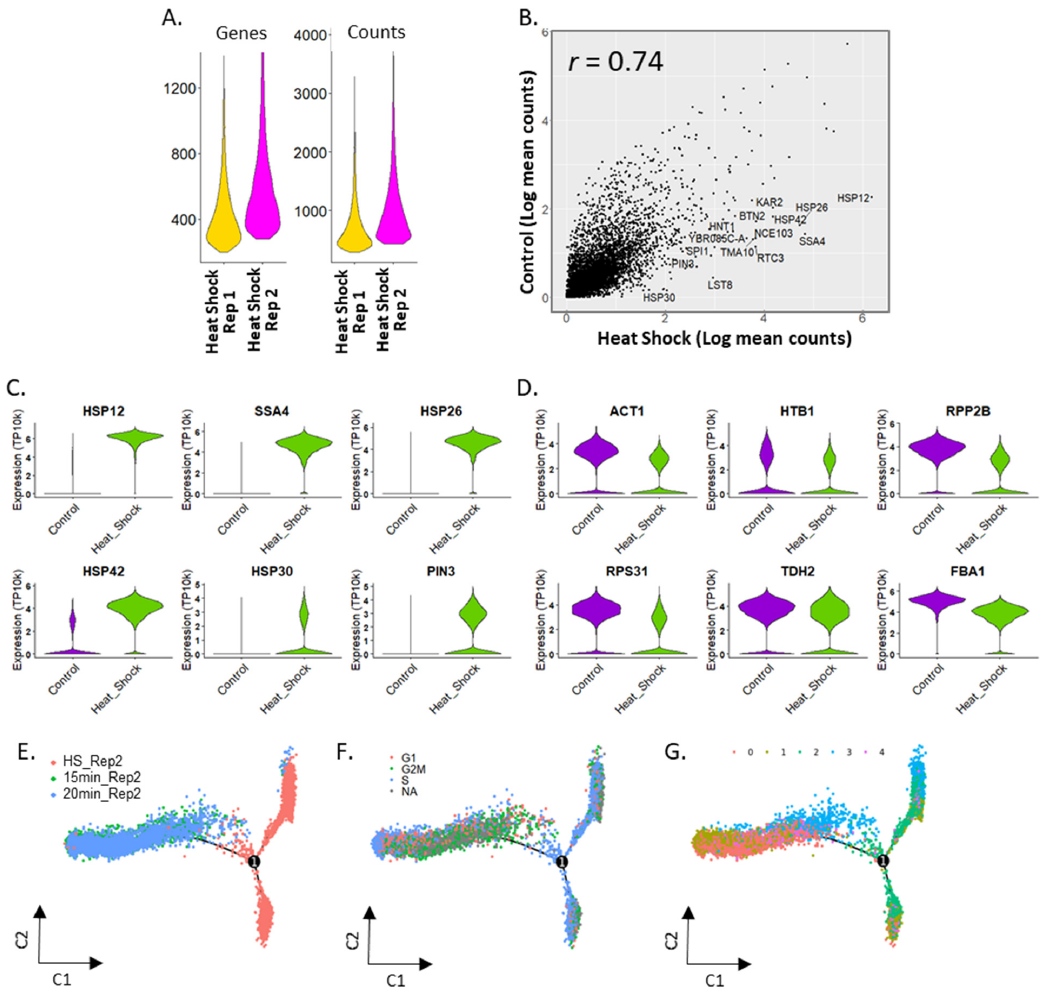
Figure 2. Heat shock treatment of 26,019 Saccharomyces cerevisiae cells profiled using mDrop-seq. ( A ) Violin plots displaying the number of genes and UMI for heat shock replicates. ( B ) Correlation be- tween average gene expression values for the control and heat shock S. cerevisiae datasets. ( C , D ) Violin plots displaying expression differences in control and heat shock datasets for ( C ) heat shock-related genes, and ( D ) “house-keeping” (actin, histones, ribosomal, and glycolysis) genes. ( E – G ) Pseudo-time trajectory of gene expression inferred from the combined control and heat-shocked S. cerevisiae dataset shown in this figure. Colors indicate: ( E ) experimental time-points, ( F ) Cell cycle stages (cells that could not be assigned to a cell cycle stage are marked NA), and ( G ) cell-type clusters shown in Figure